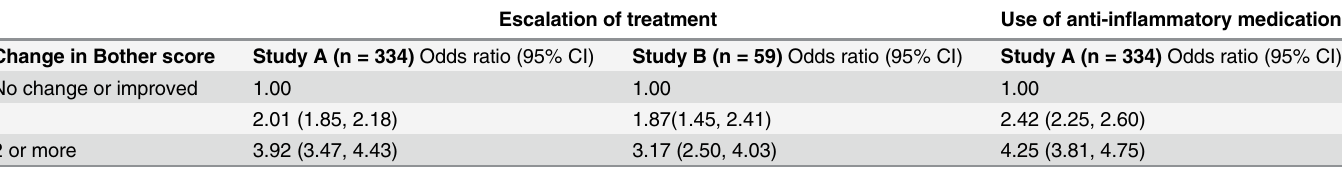
Table 4. Odds of escalation of treatment and odds of using topical anti-inflammatory medication by change in bother score compared to the previ- ous day. Escalation of